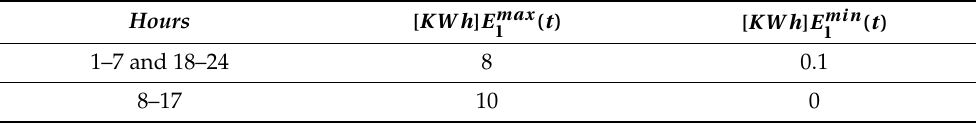
Table 3. A sample maximum and minimum allowable energy consumption for an industrial load.